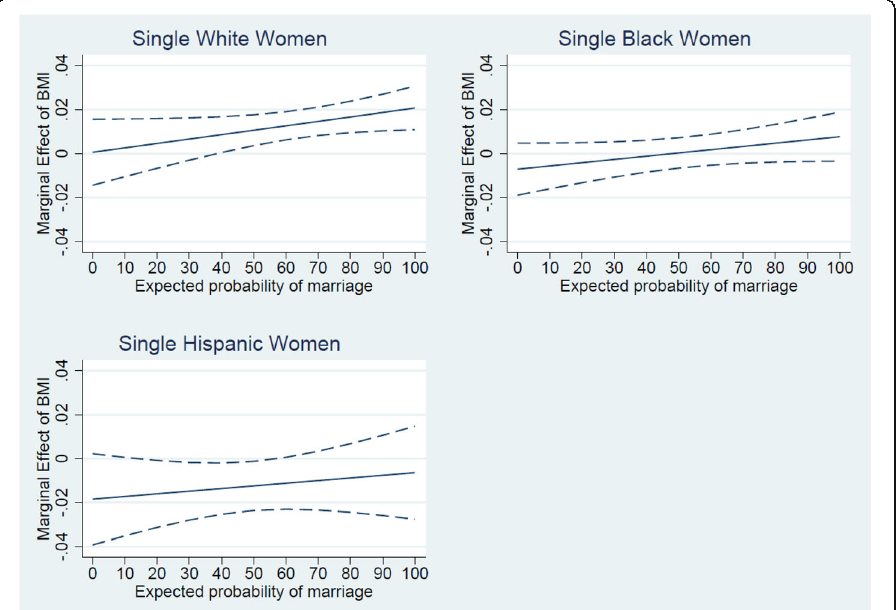
Fig. 1 Marginal effect of log hours of work for single women (with 95% confidence interval): by self-assessed probability of marriage. Note 1: Control variables include expected probability of marriage, work experience (quadratic), educational categories, dummies for whether the woman believes in traditional gender roles, whether the woman has any children, if the youngest child is below six, yearly age dummies, region of residence dummies, and year dummies. Note 2: The confidence interval reported is based on standard errors clustered at the individual